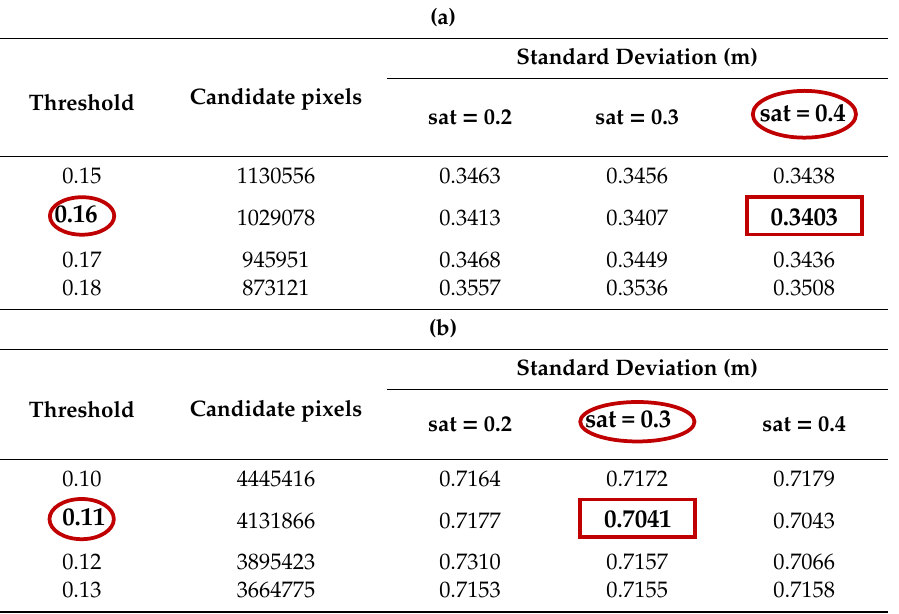
Table 2. Number of intertidal candidate pixels for the logistic regression versus application of threshold and saturation index. (a) Tagus estuary and (b) Bijagós archipelago. Red circles: threshold and saturation index selected to generate the intertidal models. Red rectangles: standard deviation of the intertidal model created after the logistic regression and the comparison with the bathymetric survey in the Tagus estuary and depths extracted from a nautical chart in the Bijagós archipelago. sat = 0.2